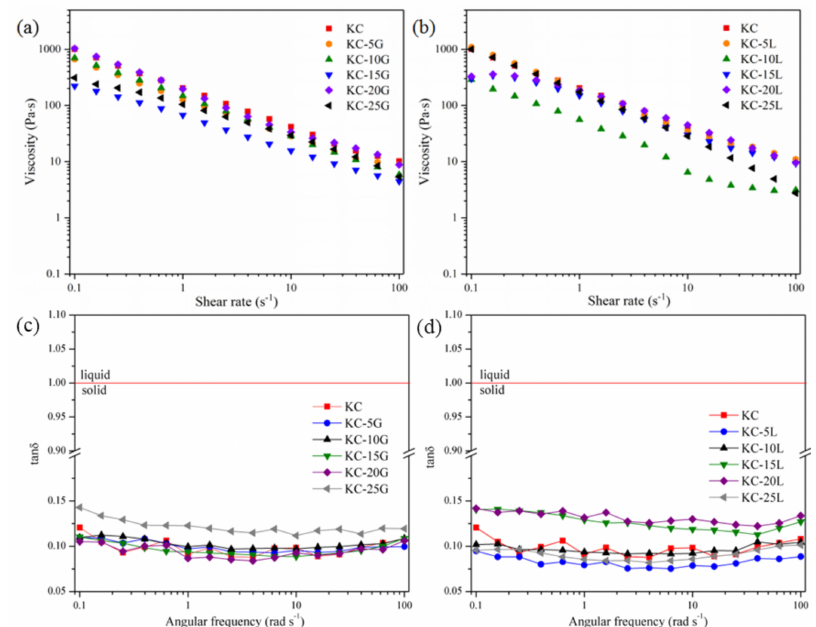
Figure 7. The steady-state shear properties ( a , b ) and the dissipation factor ( c , d ) of the